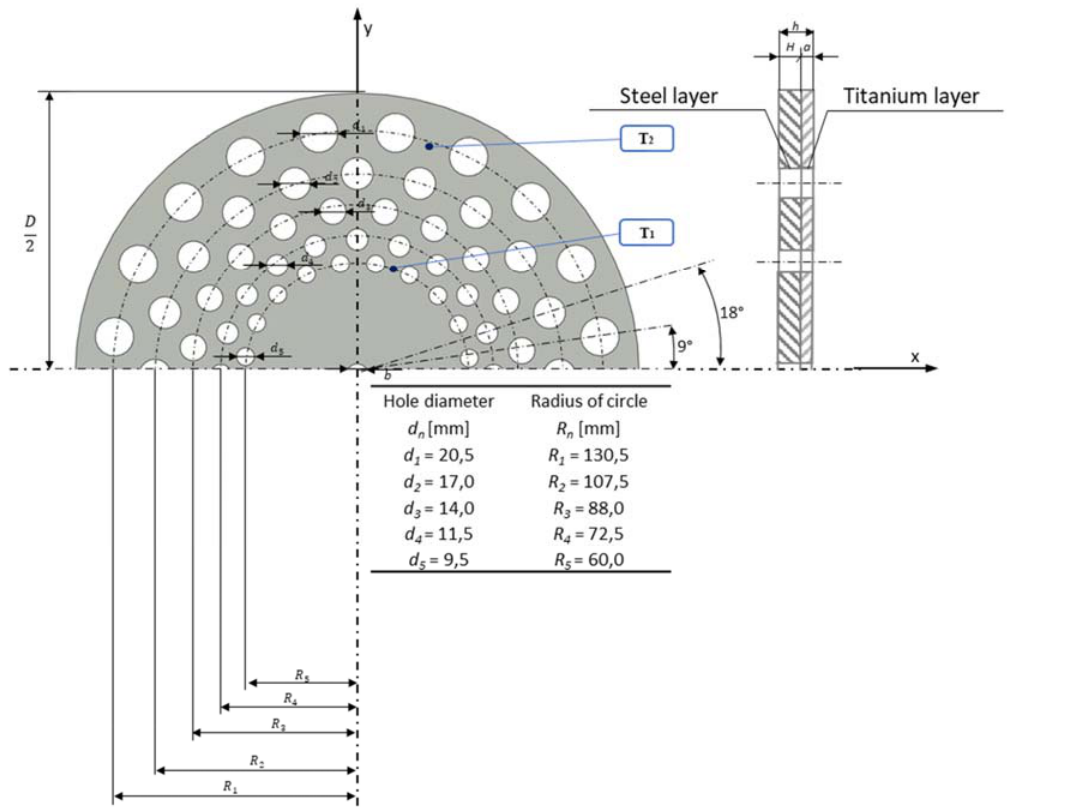
Figure 1: Model of bimetallic perforated plate consisting of steel thickness perforated plate H and titanium perforated plate thickness a containing holes with diameters d 1 ,…,d 5